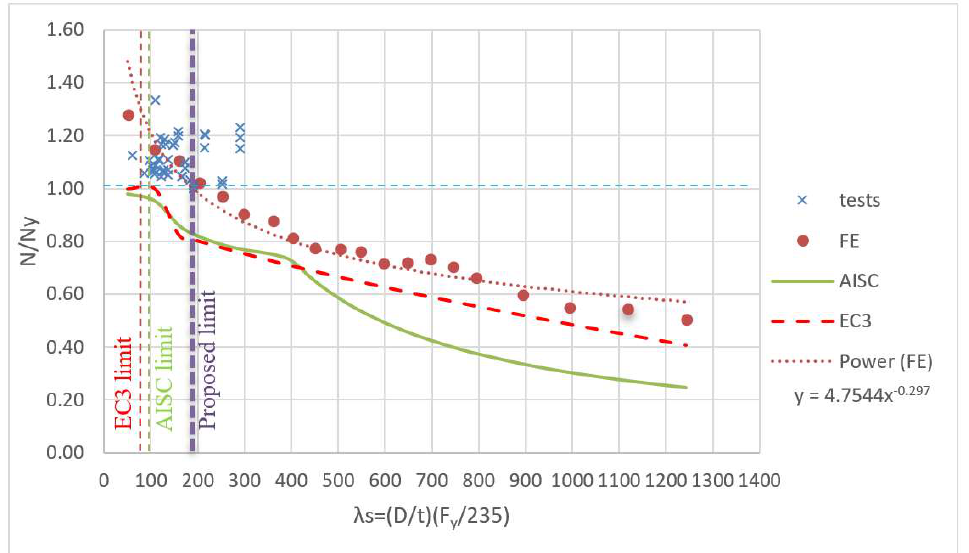
Figure 18. Comparison of normalized static axial load versus section slenderness between experimental results by others, FE by authors, and the predicted values of AISC and EC3 standards for UHSS-S1100.